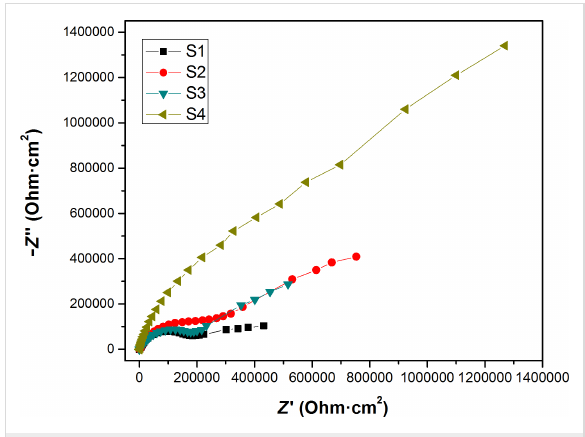
Figure 8: Nyquist diagram of the prepared samples.